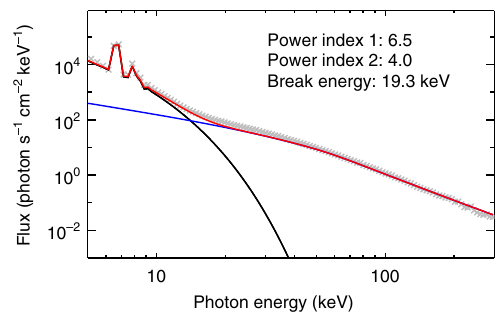
Fig. 5 HXR spectrum of the fl are and its fi tting. The integration time of the spectrum is from 03:20:56 to 03:21:20 UT. The spectrum is fi tted using a variable thermal source plus a non-thermal source with a broken power law. The gray cross signs refer to the spectral data after subtraction of the background. The modeled thermal, non-thermal components, and the overall spectrum are plotted in black, blue, and red